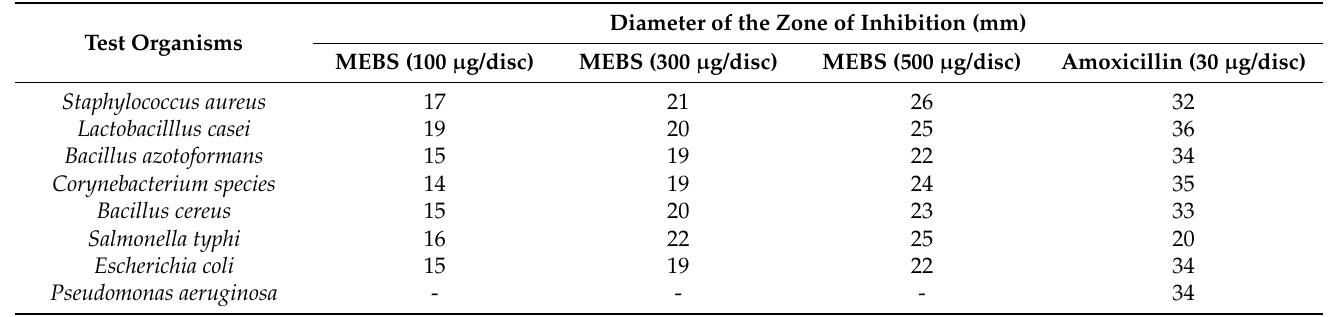
Table 5. Antibacterial activities of the test samples against several food poisonous bacteria (gram positive and gram negative).